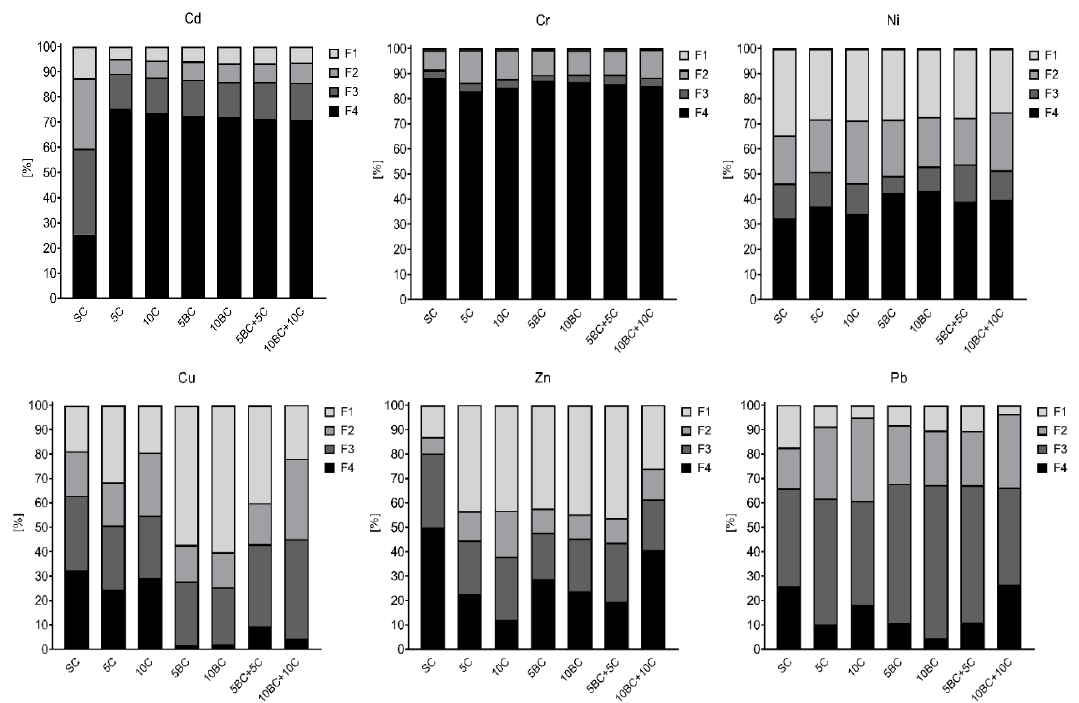
Figure 3. Speciation of Cu, Zn, Pb, Cd, Cr and Ni in amended soil—share of fractions in total metal content (100%). F1, easily soluble fraction; F2, reducible, bound to Fe and Mn oxides; F3, oxidizable, bound to organic matter; F4, residual fraction. Abbreviations of the treatments are defined in Table